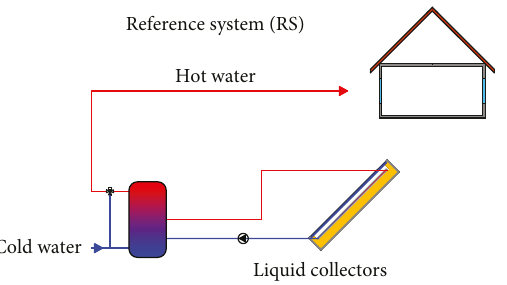
Figure 11: The con fi guration of the reference system